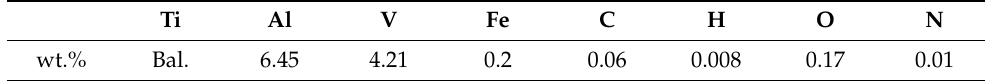
Table 1. Chemical composition of as-cast Ti-6Al-4V alloy (wt.%). Ti Al V Fe C H O N wt.% Bal. 6.45 4.21 0.2 0.06 0.008 0.17